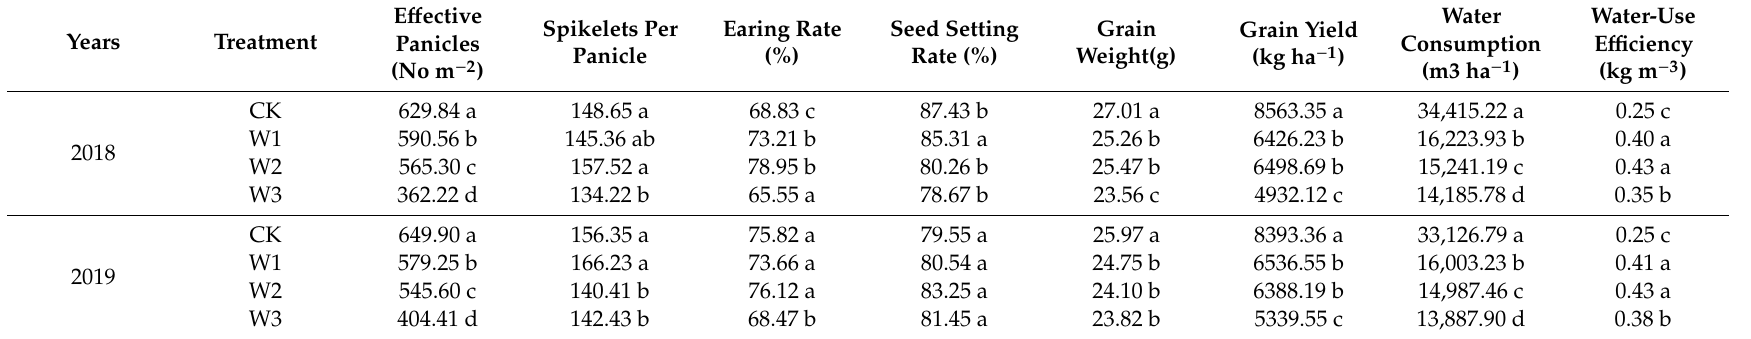
Table 5. Yield and yield components of rice under di ff erent water treatments. Di ff erent letter in the same column indicate significant di ff erences at p < 0.05.